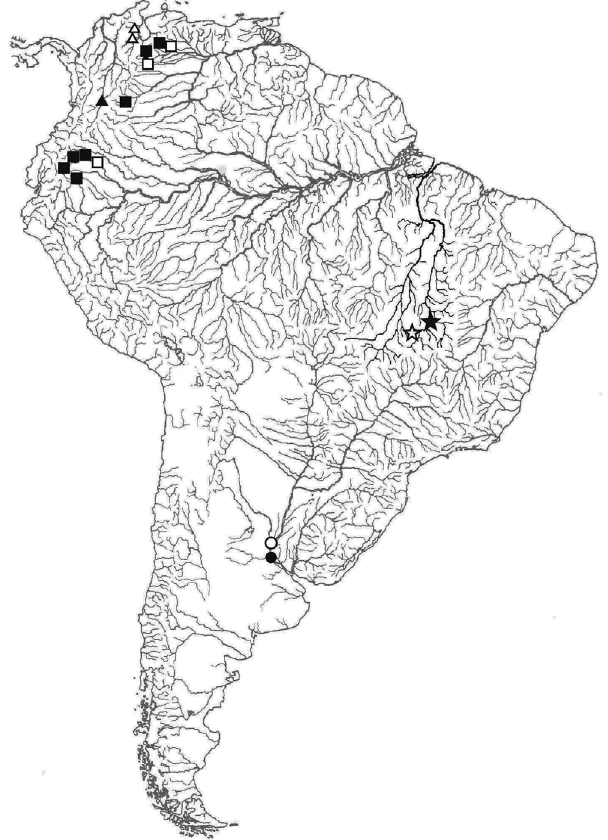
Fig. 4. Known distribution of Xypliphius species. Records of Xyliphius anachoretes represented by stars at the rio Tocantins-Araguaia system (highlighted). Type locality represented by a solid star. Other species represented are X . melanopterus (open squares); X . lepturus (solid squares); X . kryptos (open triangle); X . magdalenae (solid triangle; type locality); X . lombarderoi (open circle, type locality); X . barbatus (solid circle, type locality). Squares and solid triangle may represent more than one